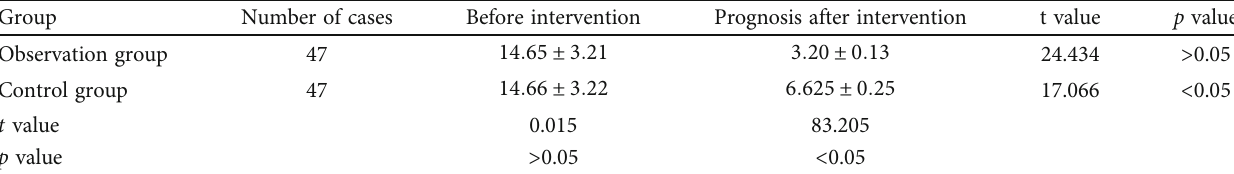
Table 3: Comparison of depression scores between the two groups before and after intervention ( x ± s ).